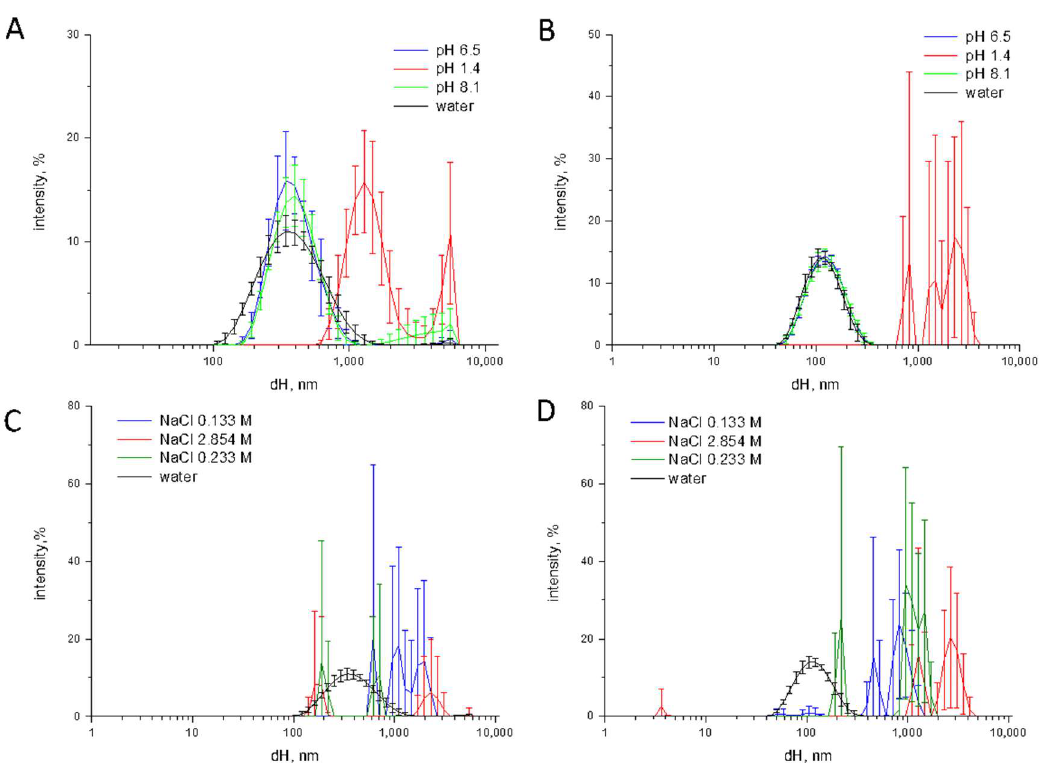
Figure 5. Effect of pH and ionic strength on size distribution of TiO 2 samples. Size distribution monitored by DLS of ( A ) TiO 2 -FG; and ( B ) TiO 2 -NM2 in water at pH 6.5, 1.4 and 8.1; size distribution of ( C ) TiO 2 -FG; and ( D ) TiO 2 -NM2 in solutions of NaCl with different ionic strength.